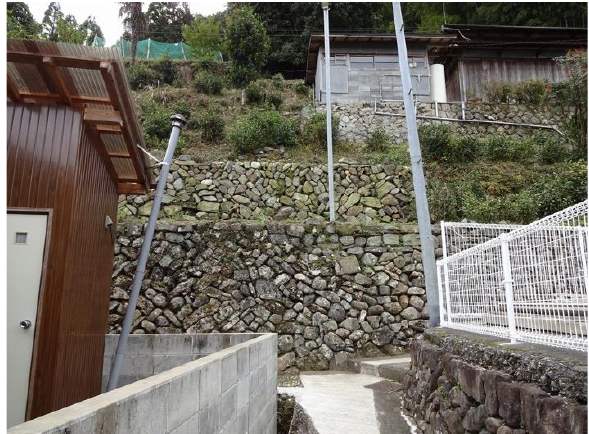
Figure 3. Basement raised and covered by stones of the Agariya in Figure